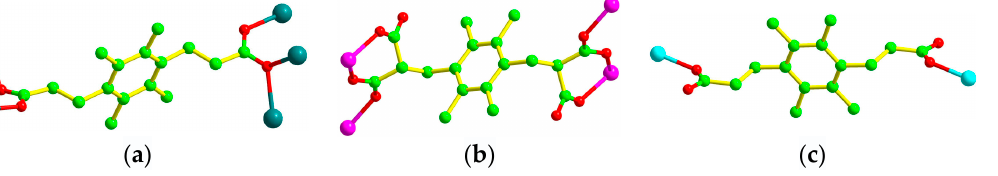
Figure 1. Coordination patterns of acids in complexes. ( a ) The coordination pattern of X 2 − in 1 . ( b ) The coordination pattern of X 2 − in 3 . ( c ) The coordination pattern of X 2 − in 4 . connected to six equivalent nodes through six X 2 − ligands. Each X 2 − links two [CdO] units,